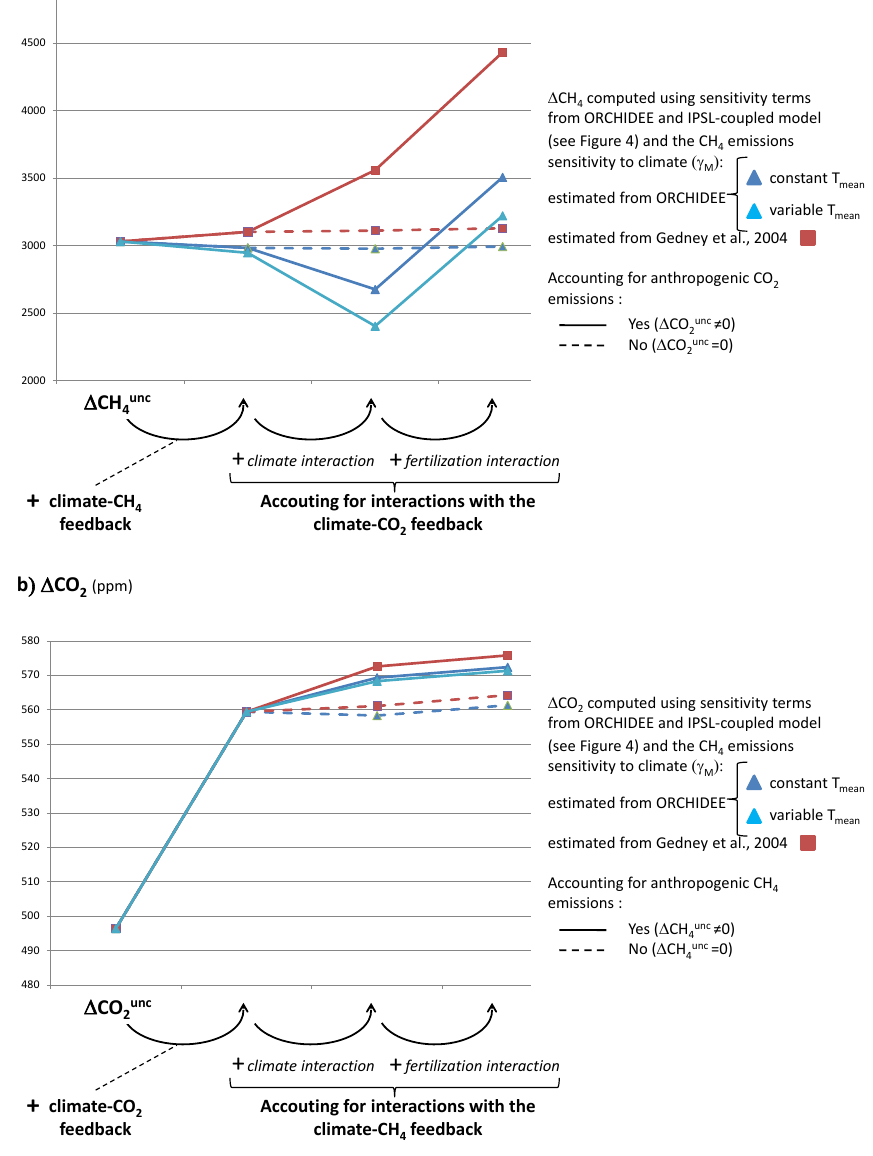
Fig. 5. Evolution of the difference in CH 4 (a) and CO 2 (b) atmospheric concentration between future and pre-industrial time accounting or not for feedback with climate and interactions with the other feedback. “ Climate interaction ” and “ Fertilization interaction ” report to definitions into Sect. 2.2 of the manuscript. To reminder, concerning CH 4 (respectively CO 2 ), “climate interaction” means that climate is also a function of CO 2 (respectively CH 4 ). Accounting for “fertilization interaction” consists in accounting for wetland CH 4 emissions dependence to atmospheric CO 2